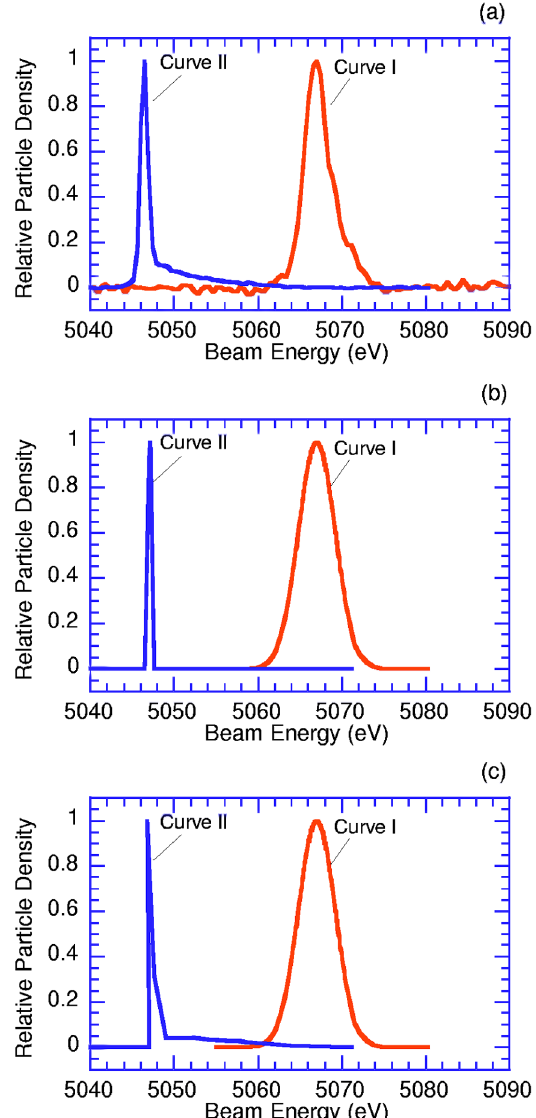
FIG. 12. (Color) Comparison of the experimental results with theory. (a) Experimental results of beam energy spread for two different currents inside the device. Curve I for current of 0.2 mA ( (cid:19) (cid:14) 0 : 062 , estimated), rms energy spread of 2.2 eV, FWHM of 3.4 eV. Curve II for current of 2.6 mA ( (cid:19) (cid:14) 0 : 8 , estimated), rms energy spread of 3.2 eV, FWHM of 1.1 eV. (b) Simulation results of beam energy spread for different normal- ized current densities. Curve I for (cid:19) (cid:3) 0 : 062 , rms energy spread of 2.2 eV, FWHM of 5.1 eV. Curve II for (cid:19) (cid:3) 1 : 2 . Ideally, curve II should be a delta function and have an energy spread of zero. (c) Simulation results with the correction of the two-dimensional effect. Curve I for (cid:19) (cid:3) 0 : 062 , rms energy spread of 2.2 eV, FWHM of 5.1 eV. Curve II for (cid:19) (cid:3) 1 : 2 , rms energy spread of 5.1 eV, and FWHM of 0.49 eV.